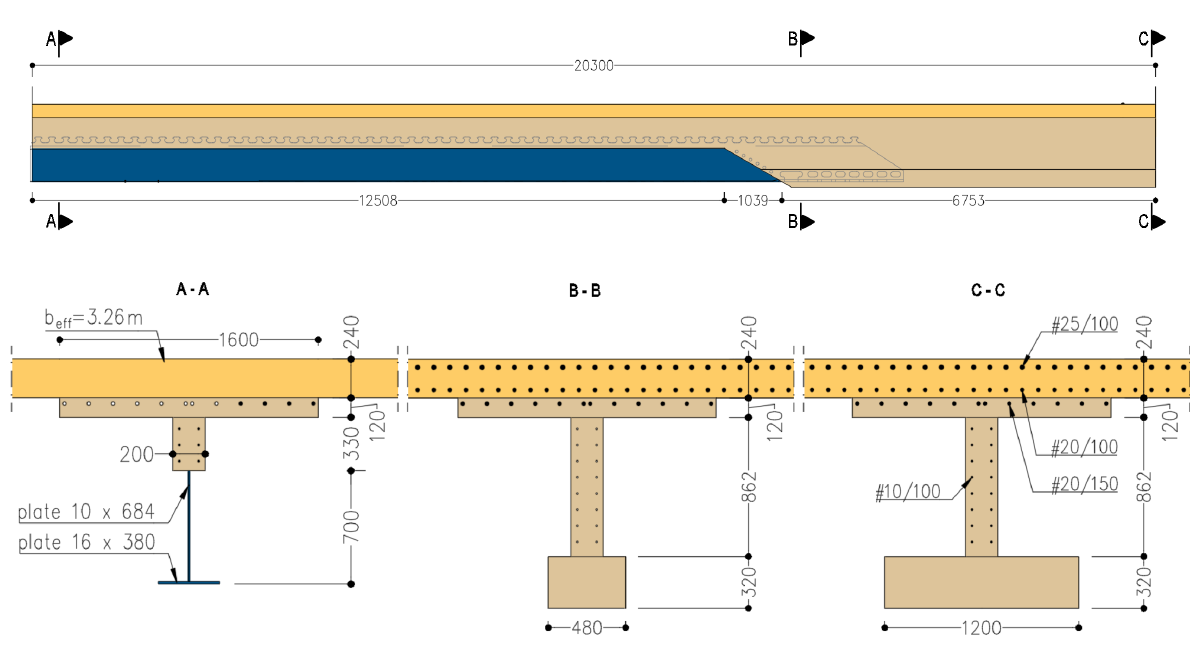
Figure 12: Hybrid beam assumed for FE analysis (rebars only in the tensile regions are displayed).